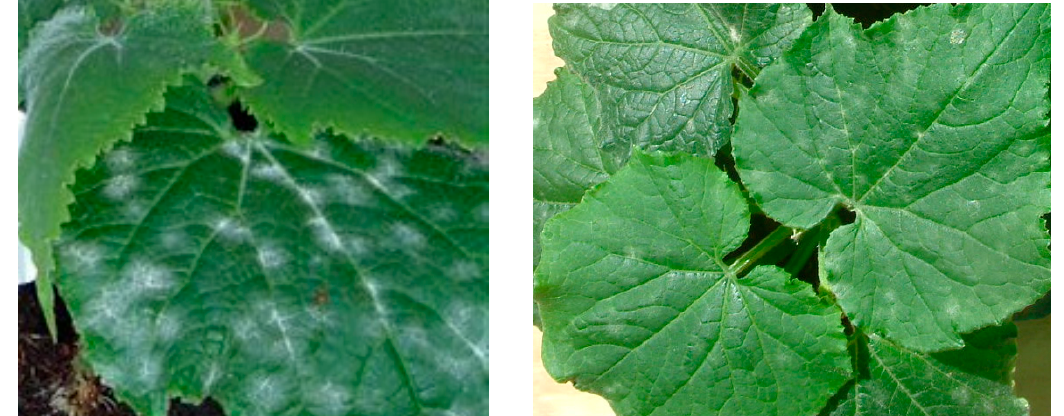
Figure 4. A section of fungal hyphae of M. fijiensis in the intracellular space of the mesophyll tissue of Timorex Gold-treated banana leaves: (a) at low magnification (×20,000 = a) and (b) at high magnification (×50,000). Note the destruction and breakdown of cell wall causing leakage of cell content.